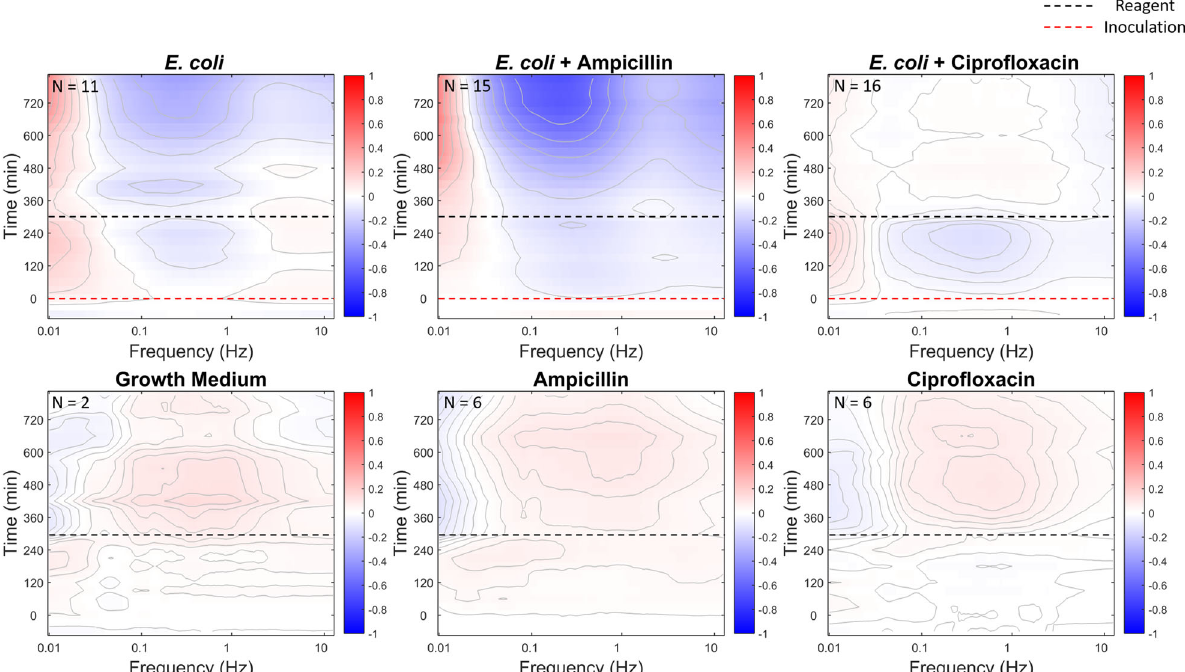
Fig. 6 Time evolution of the spectral density of DLD-1 sentinels. The top row shows the (intensity normalized) spectrogram responses for the infected DLD-1 sentinels. The dashed red line is the time of bacterial inoculation, and the dashed black line is the time of antibiotic application. The bottom row shows the responses of the DLD-1 sentinel controls without bacterial infection. E. coli infection induces broadband suppression of activity (top of left column). Treatment with ampicillin (middle column) has little effect on the infected tissue, but cipro fl oxacin (right column) halts and reverses the infection, returning the tissue to a response similar to the uninfected control. The replicate numbers are shown at the top-left corner of the spectrogram